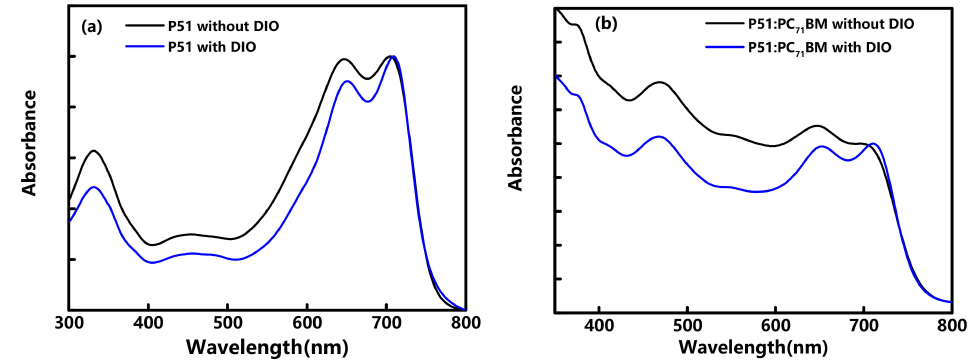
Figure 1. ( a ) Steady-state absorption spectra of the pristine P51 with / without 1,8-diiodooctane (DIO) additive; ( b ) steady-state absorption spectra of P51:PC 71 BM blend with / without DIO